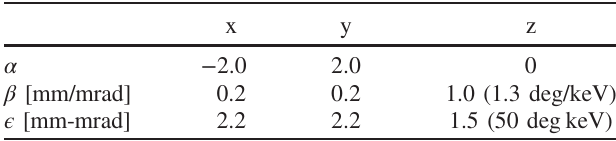
TABLE II. rms parameters for 100 mA Gaussian initial dis- tribution. Emittances are unnormalized.